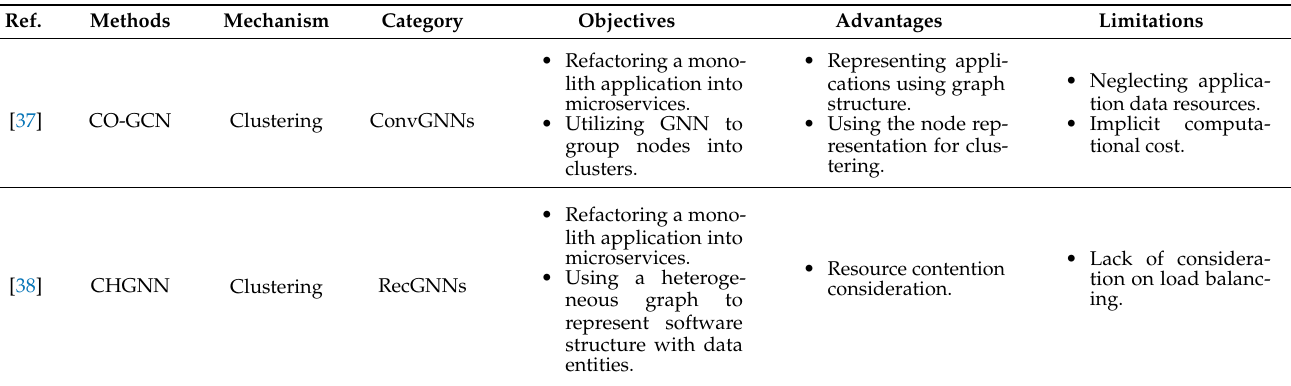
Figure 6. General procedure for application refactoring algorithms using GNNs for microservice architecture. Table 7. Summary of software decomposition